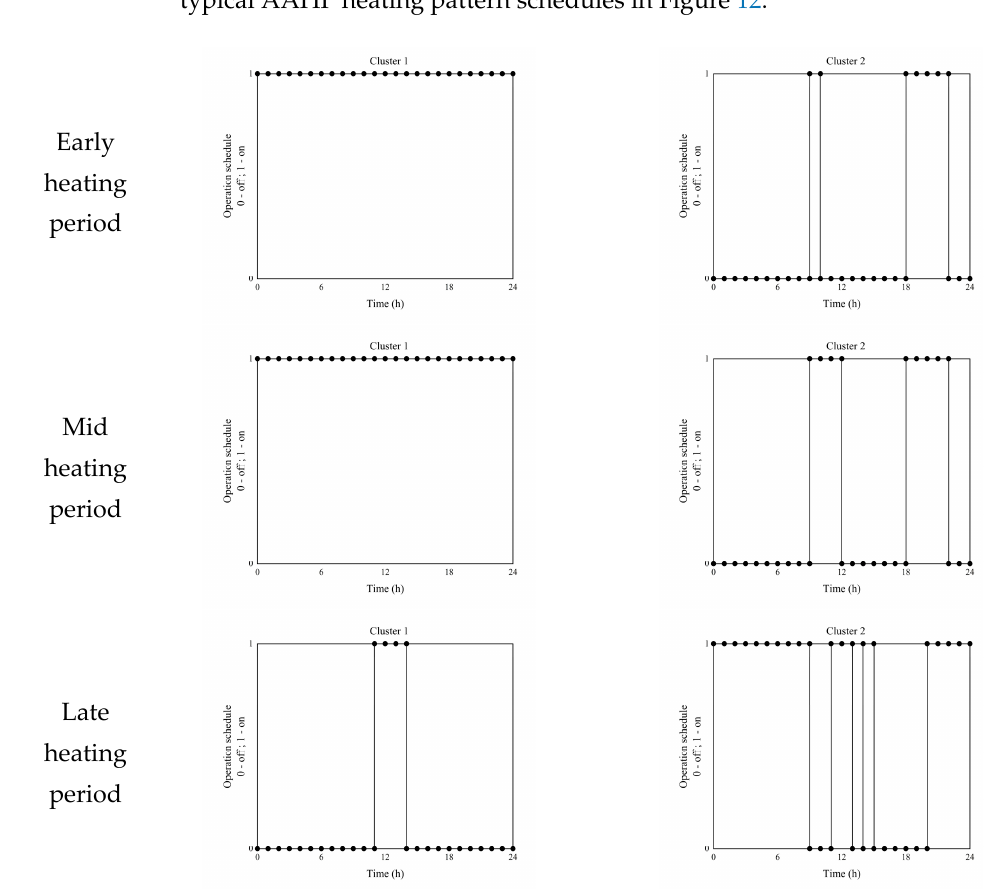
Figure 12. AAHP heating pattern schedules for different heating periods in Shanxi’s living rooms. During the early heating period, there are two heating patterns of AAHP heating in the living rooms in Shanxi province. Cluster 1 has a proportion of about 34%, which rep- resents the “always-on user”. Cluster 2 accounted for 66% of the early heating period. Overall, more than half of the occupants used the AAHP for intermittent heating in the morning and evening until going to bed. The heating operation time periods were from 9:00 to 10:00 and from 18:00 to 22:00, with a heating duration of 5 h. There are two heating patterns during the mid heating periods. Cluster 1 accounted for about 16%, with continuous heating all day; in Cluster 2 (accounting for about 84%), the heating operation time periods were from 9:00 to 10:00 and from 18:00 to 22:00, and the heating duration was 7 h a day. There are two heating patterns in the late heating period. Cluster 1 (accounting for 74%) mainly ran around noon; the heating operation time periods were from 11:00 to 14:00, with the heating duration being 3 h. Cluster 2 (accounting for 26%) turned on the AAHP at noon and the whole night and the heating operation time periods were 12:00 to 14:00, 15:00 to 16:00, and 20:00 to 10:00 the next day, with the heating duration being 15 h. In the rural areas of Shanxi province, during the different heating periods, some res- idents will turn on the AAHP for heating from 18:00 to 24:00, which indicates that a large number of residents will heat their homes before going to bed in the evening. At this time of day, rural households have the highest occupancy, and they prefer to use the AAHP to heat their living rooms and turn them off before going to bed.